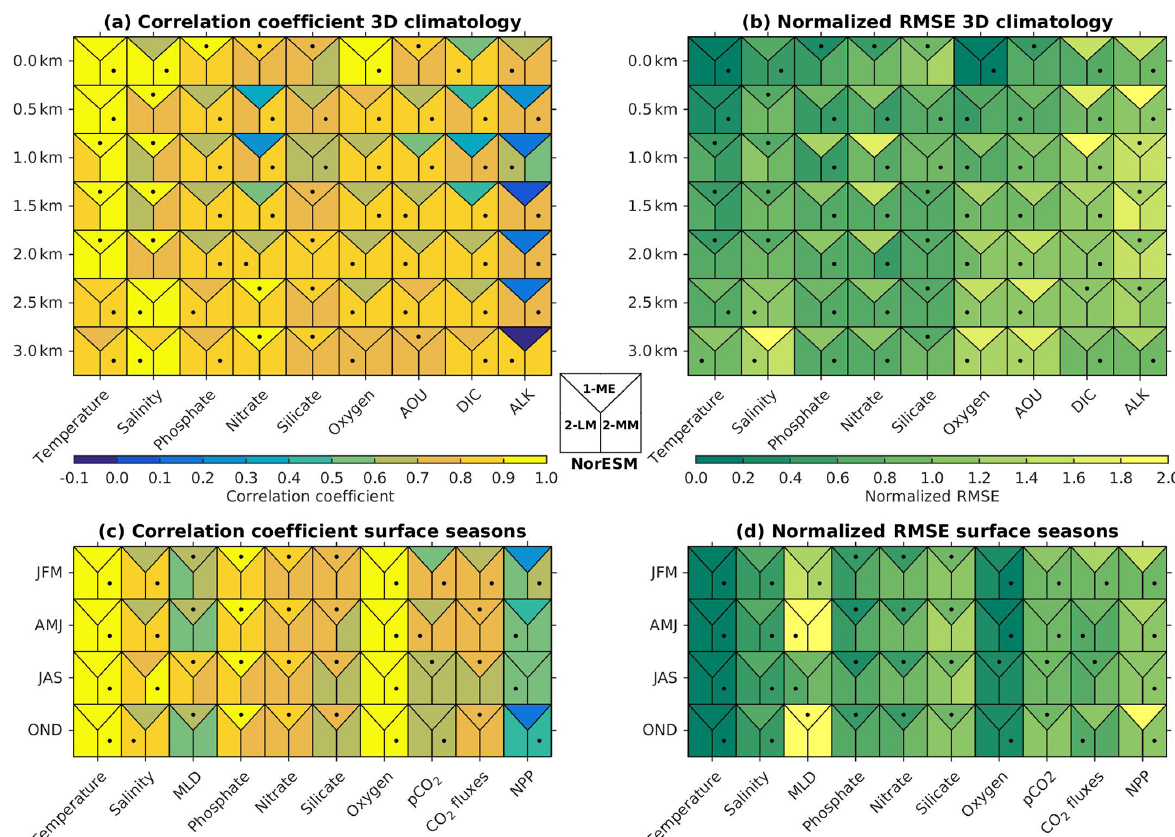
Figure 2. Summary of (a, c) spatial correlation coefficients and (b, d) normalized RMSE between the observations and models (NorESM1- ME, NorESM2-LM, and NorESM2-MM). In all (a, b) 3D fields, the metric values are computed over a 2D horizontal global domain ranging from the surface to 3km of depth, while for (c, d) seasonal metrics, only surface values are evaluated. Each square contains three metric scores, i.e. for NorESM1-ME (top), NorESM2-LM (bottom-left), and NorESM2-MM (bottom right). Black dots indicate which model performs the